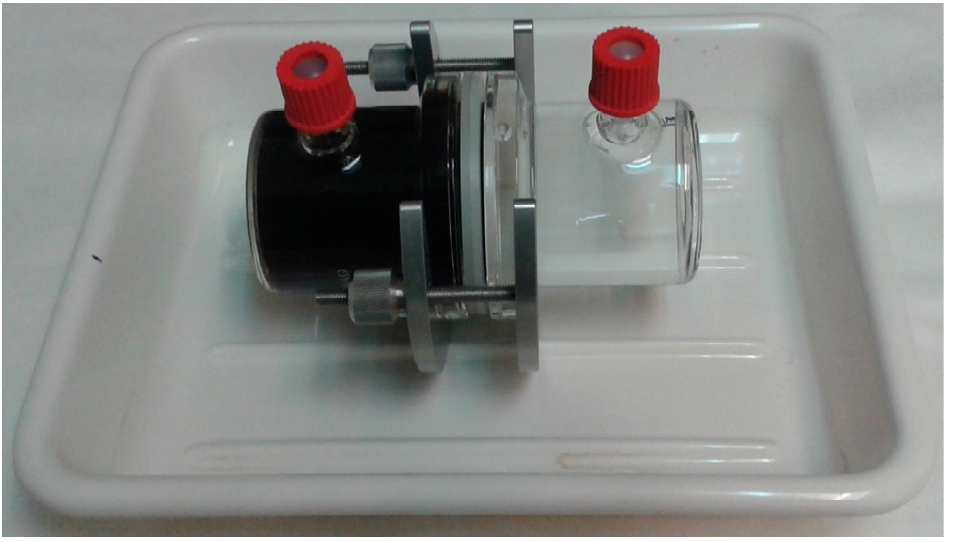
Figure 4. Image of the experimental cell selected for testing SILMs.